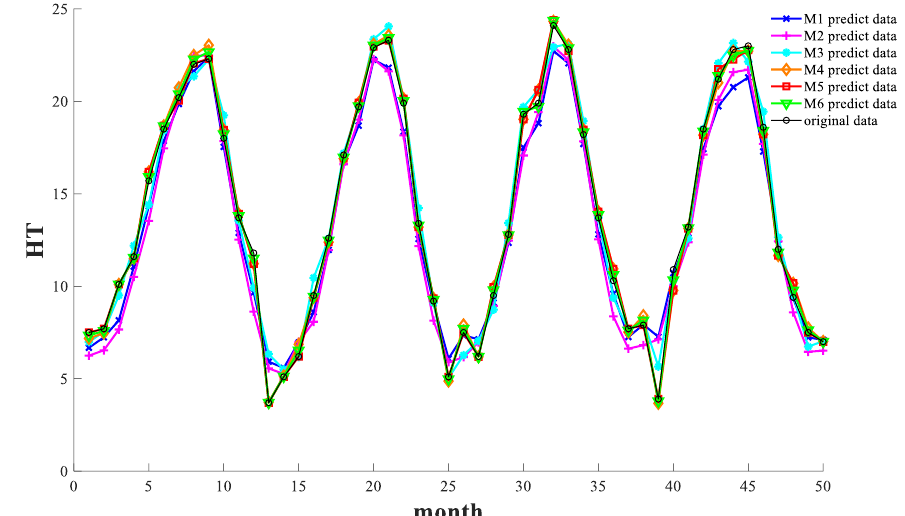
Figure 13. Predicting effect of the test highest temperature (unit: °C).